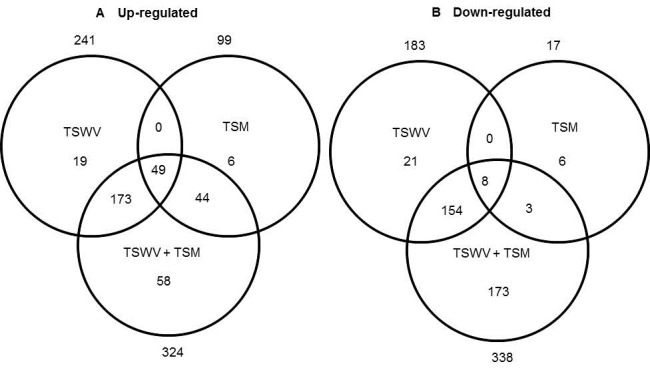
Venn diagrams depicting number of unique and shared differentially-expressed genes.